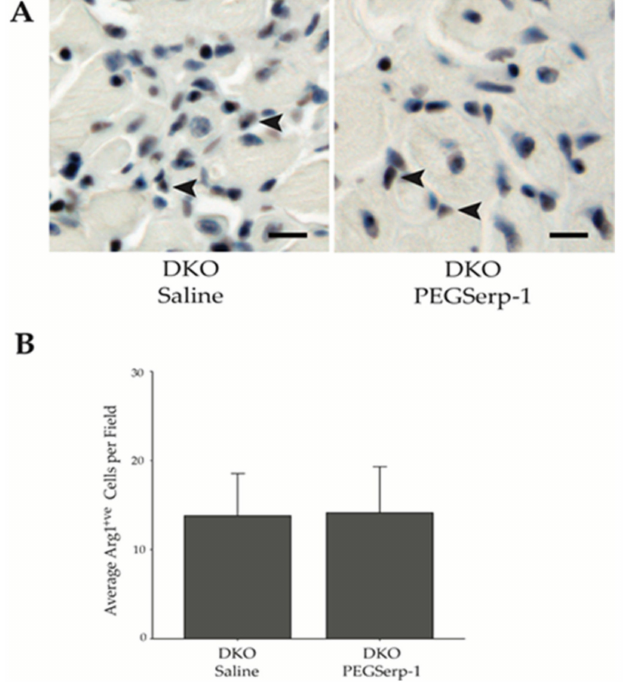
Figure 4. PEGSerp-1 does not alter Arg1+ve M2a macrophage infiltration. ( A ) Representative images of Arg1+ve M2a macrophage in the diaphragm of DKO mice treated with PEGSerp-1 or saline. IHC was performed to detect Arg1+ve single cells, arrowheads indicate example single cells. Scale bars = 10 µ m. ( B ) The average number of Arg1+ve cells/field was not significantly different ( p = 0.84) when comparing PEGSerp-1- and saline-treated DKO mice. Data are presented as average positive cells per field ±